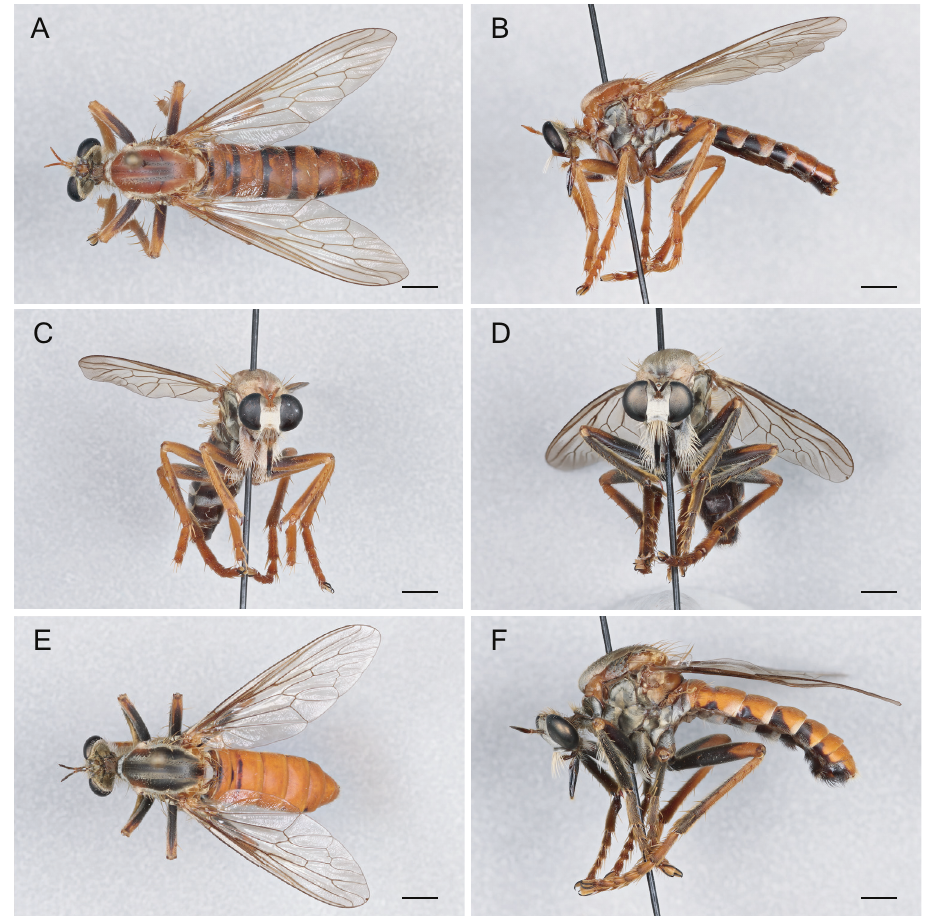
Figure 15. Saropogon hypomelas Loew, 1866 Female (USNMENT01830080): A dorsal view B lateral view C anterior view; Male (UCBMEP0280599): D anterior view E dorsal view F lateral view. Scale bars: 2